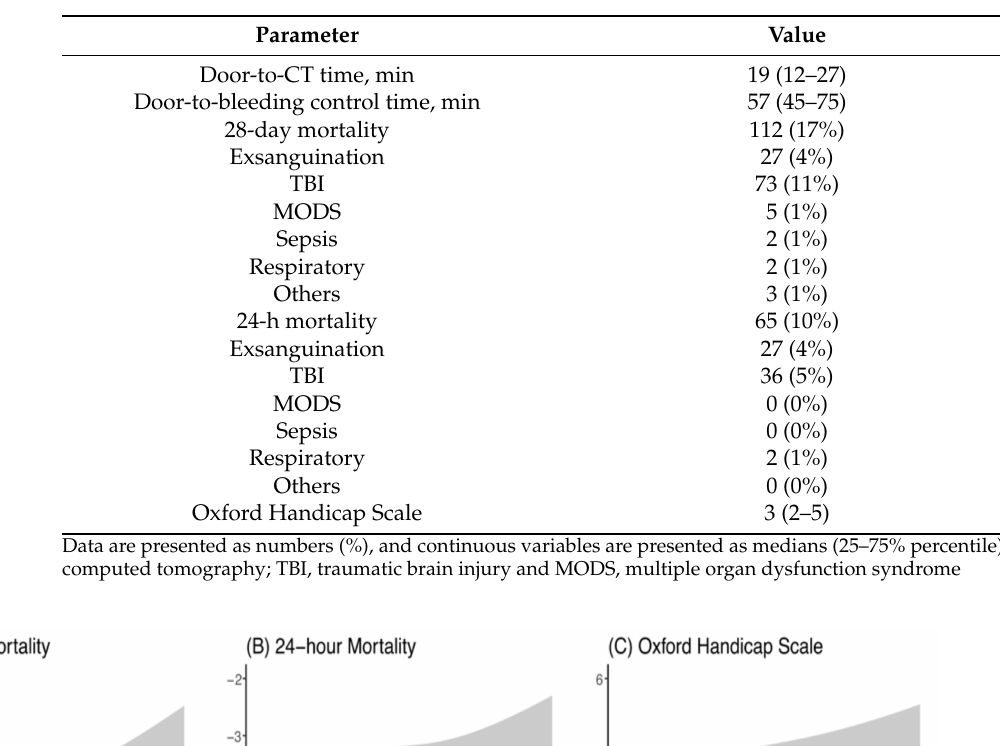
Table 2. Outcome data.